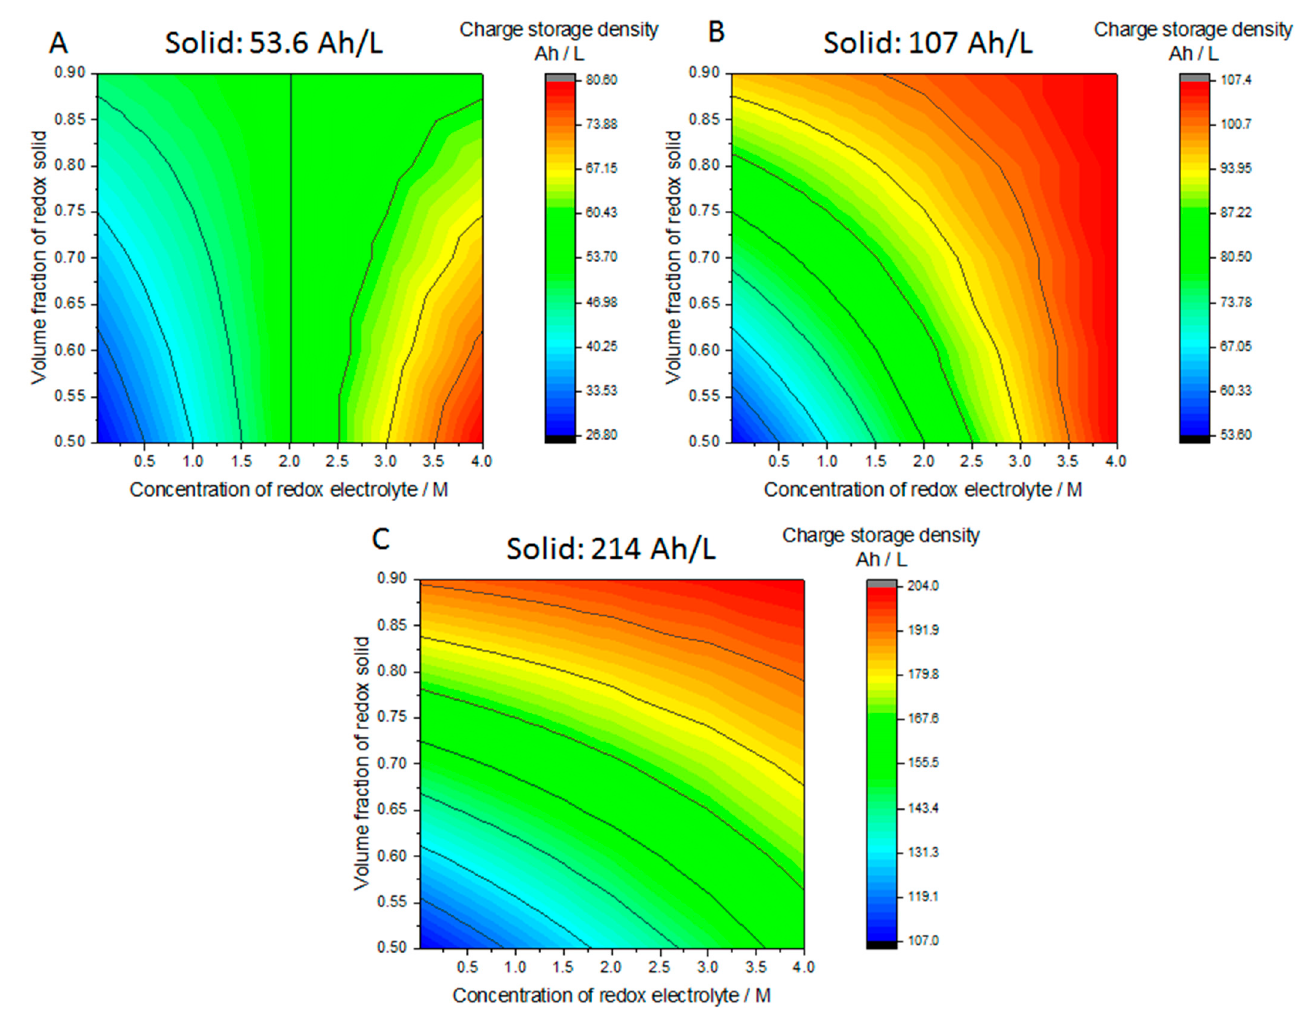
Figure 11. Volumetric charge storage capacity of solid boosted flow battery considering the concentration of the redox electrolyte and the volume fraction of the solid materials. The concentration of the redox active solid is: ( A ) 2 M; ( B ) 4 M; ( C ) 8 M. The volume fraction of additives is considered to be 0, and the number of transferred charge is 1 for all the reactions.